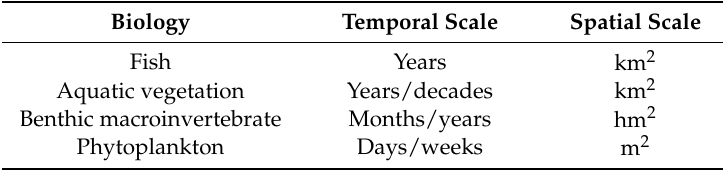
Table 2. Different biological characteristics and their spatial and temporal scales in basin [26].